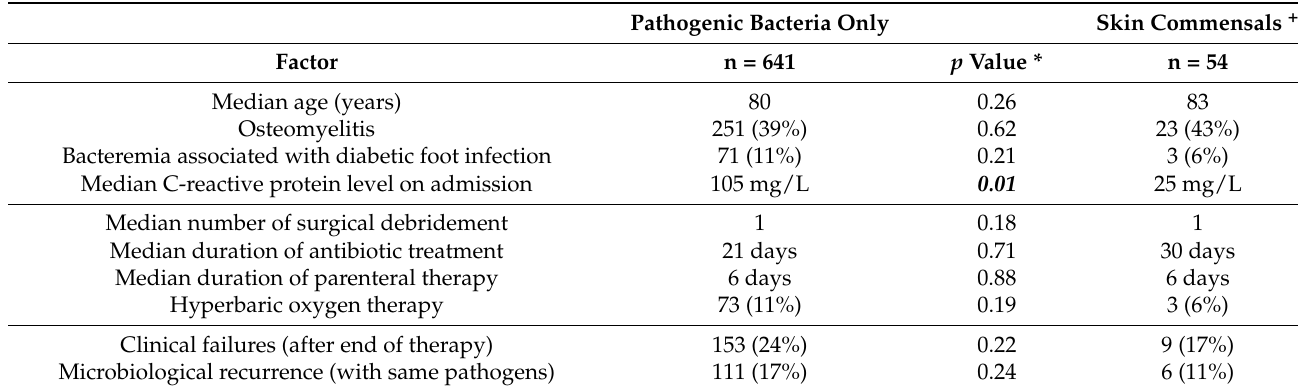
Table 1. Comparison of selected factors in patients with diabetic foot infections with skin commensals versus pathogenic bacteria.